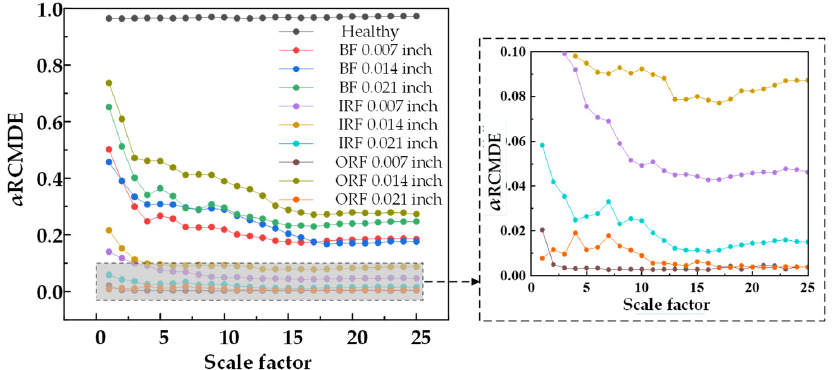
Figure 8. α RCMFE entropy values of 25 scale factors under different damage degrees.